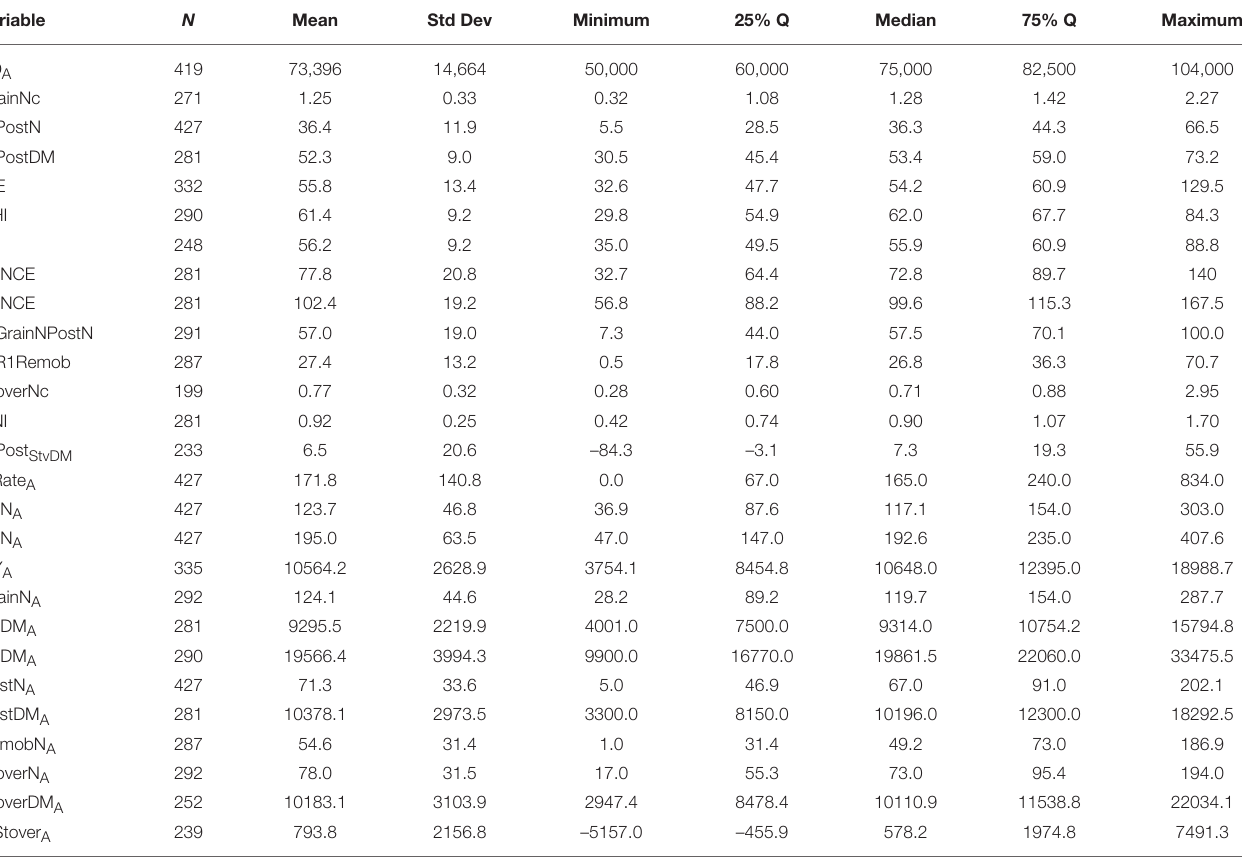
TABLE 3 | Summary statistics based on per unit area for the New Era data